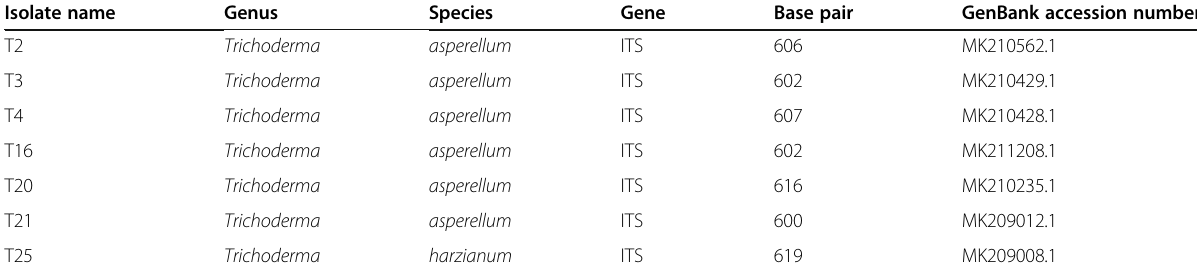
Table 1 Reference sequences retrieved for phylogenetic analysis from